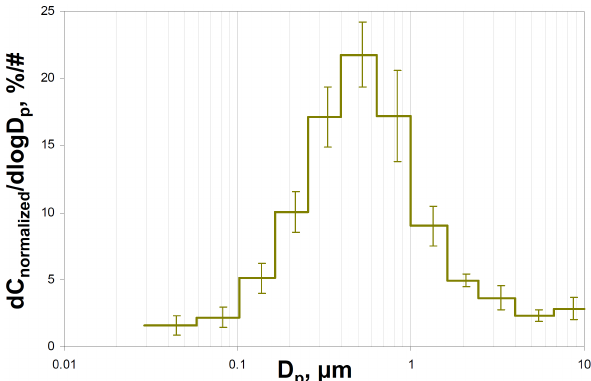
Figure 2 Fig. 2. Averaged OC-size-distribution (obtained from the 24-h LPI measurements, error bars correspond to one standard